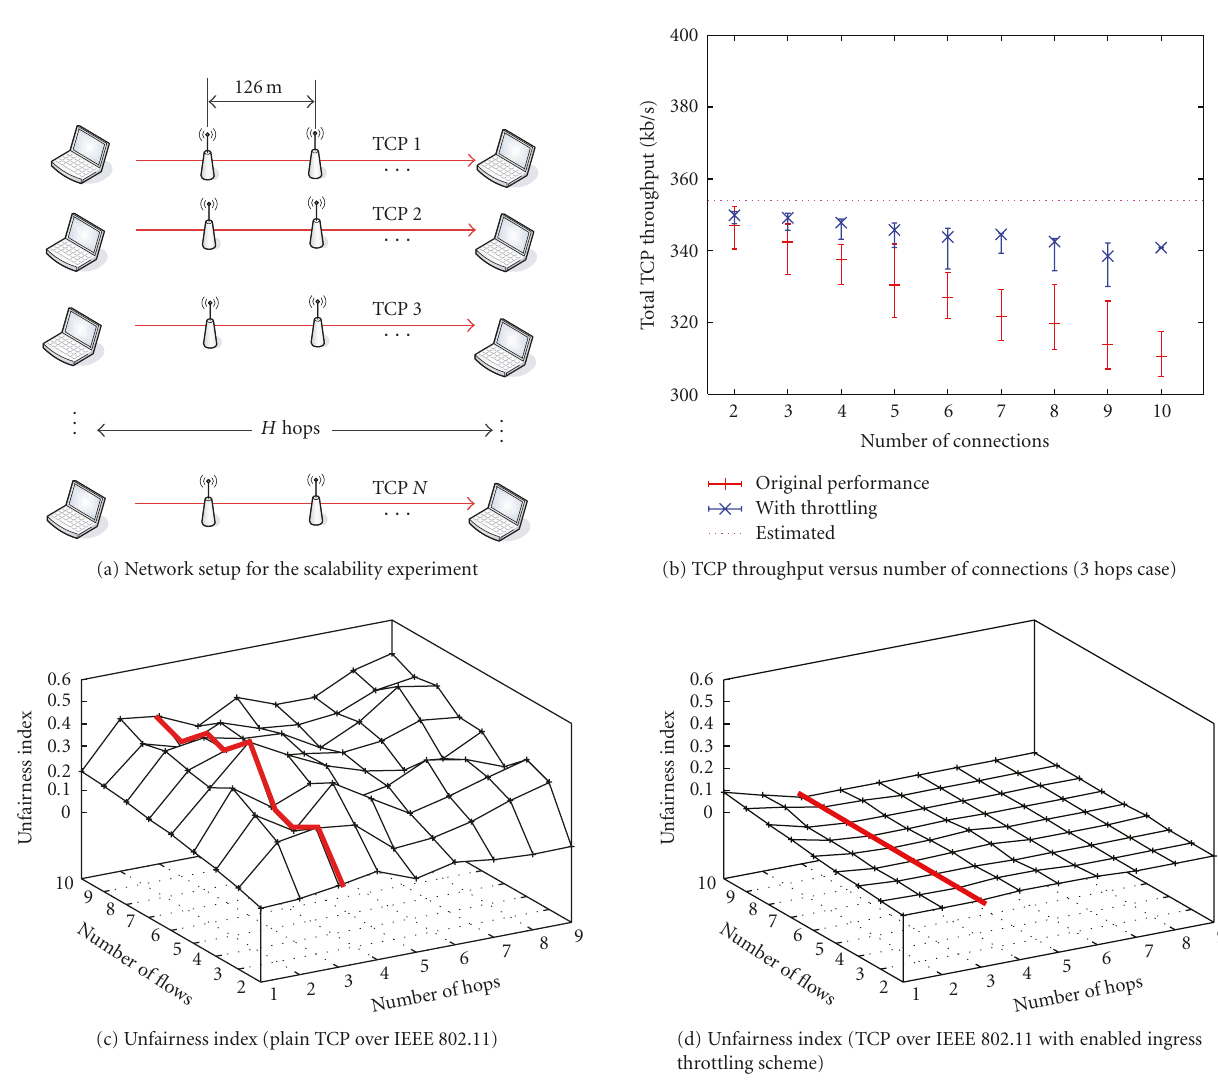
Figure 6: TCP unfairness index and TCP throughput